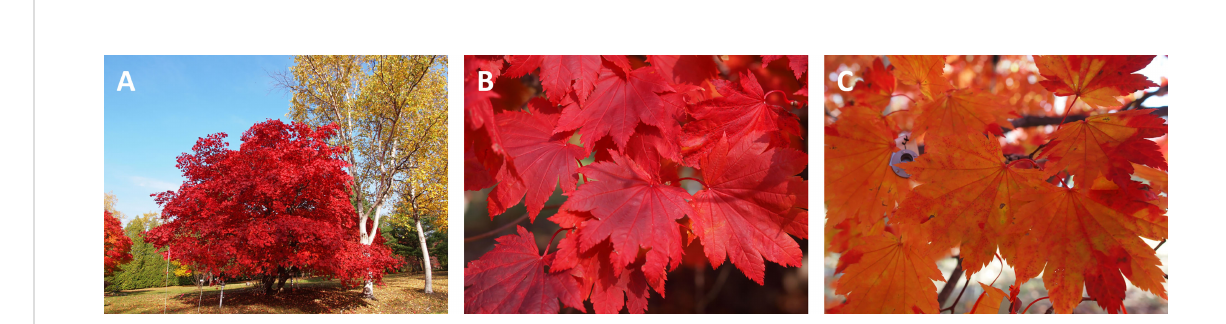
FIGURE 1 Autumn coloring in an adult tree of fullmoon maple ( Acer japonicum ) (A) in outer-canopy (B) and inner-canopy (C) leaves. Photographs were taken on 26 Oct, 2021, at the arboretum of Hokkaido Research Center, Forestry and Forest Products Research Institute, in Sapporo (43.0°N, 141.4°E; 180 m